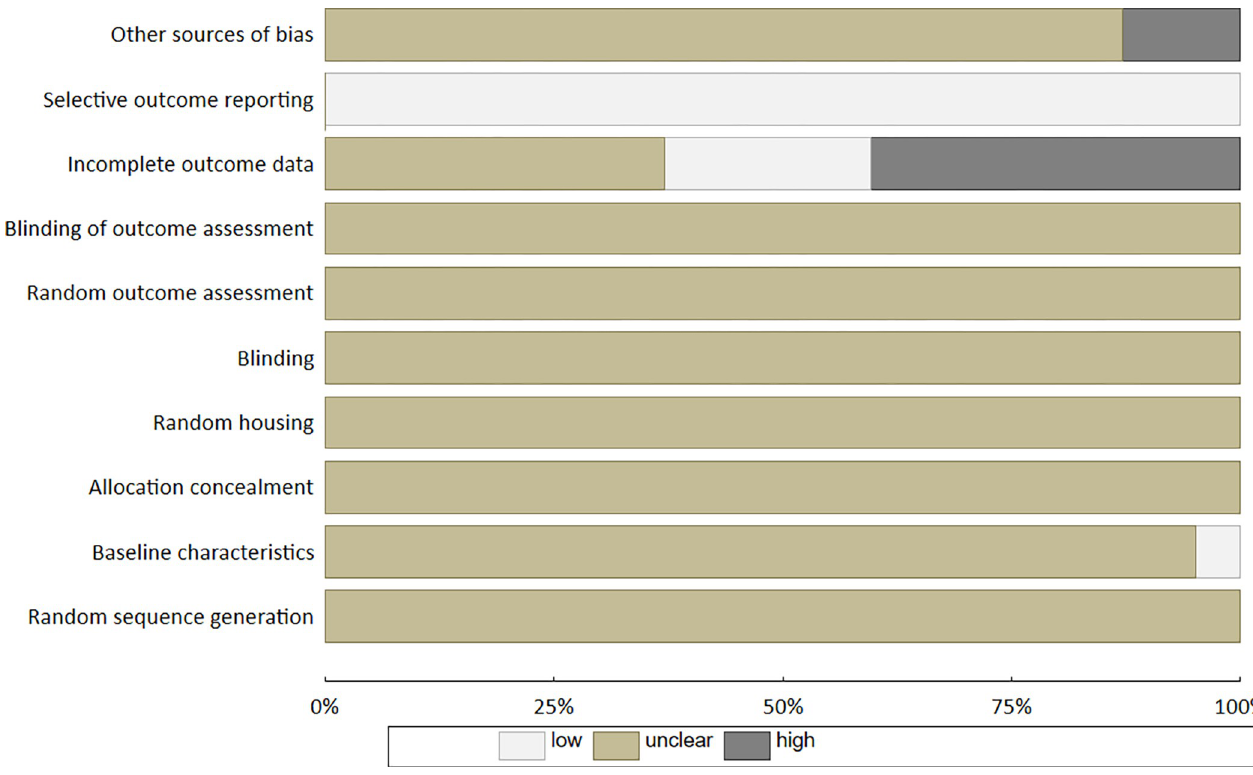
Fig 6. Summary of risk of bias adopted from Hooijmans et al (2014)